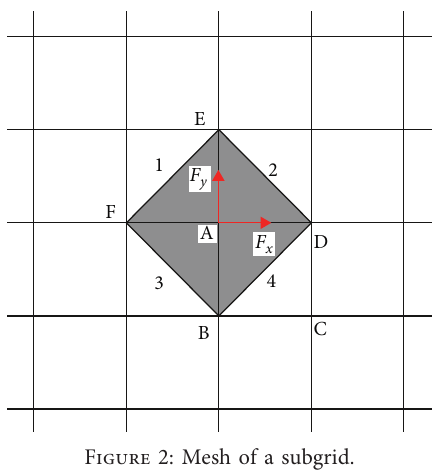
Figure 2: Mesh of a